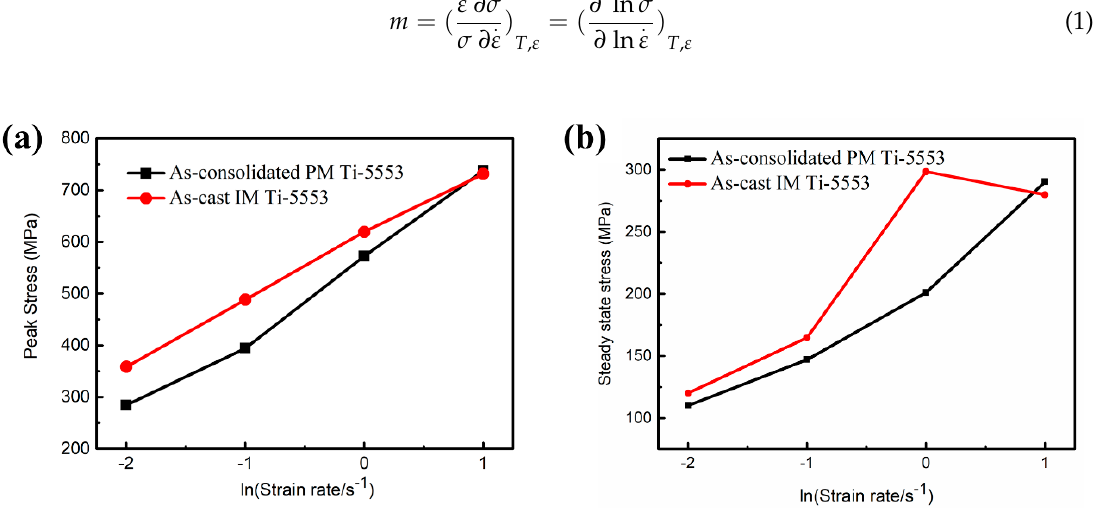
Figure 9. Comparison of the flow stress of the PM and the IM Ti-5553 alloys, at 700 °C, and various strain rates: ( a ) peak stress; and ( b ) steady-state stress ( ε = 1.2).